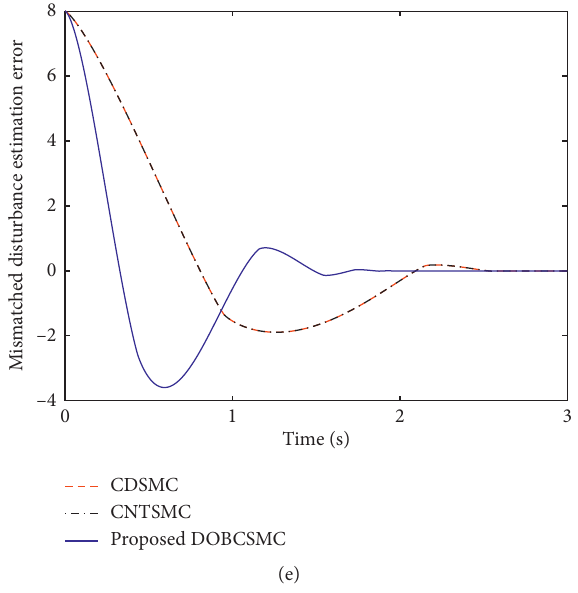
Figure 4: Simulation results of Scenario II. Table 3: Control performance of ESMC, CDSMC, CNTSMC, and DOBCSMC for Scenario II.